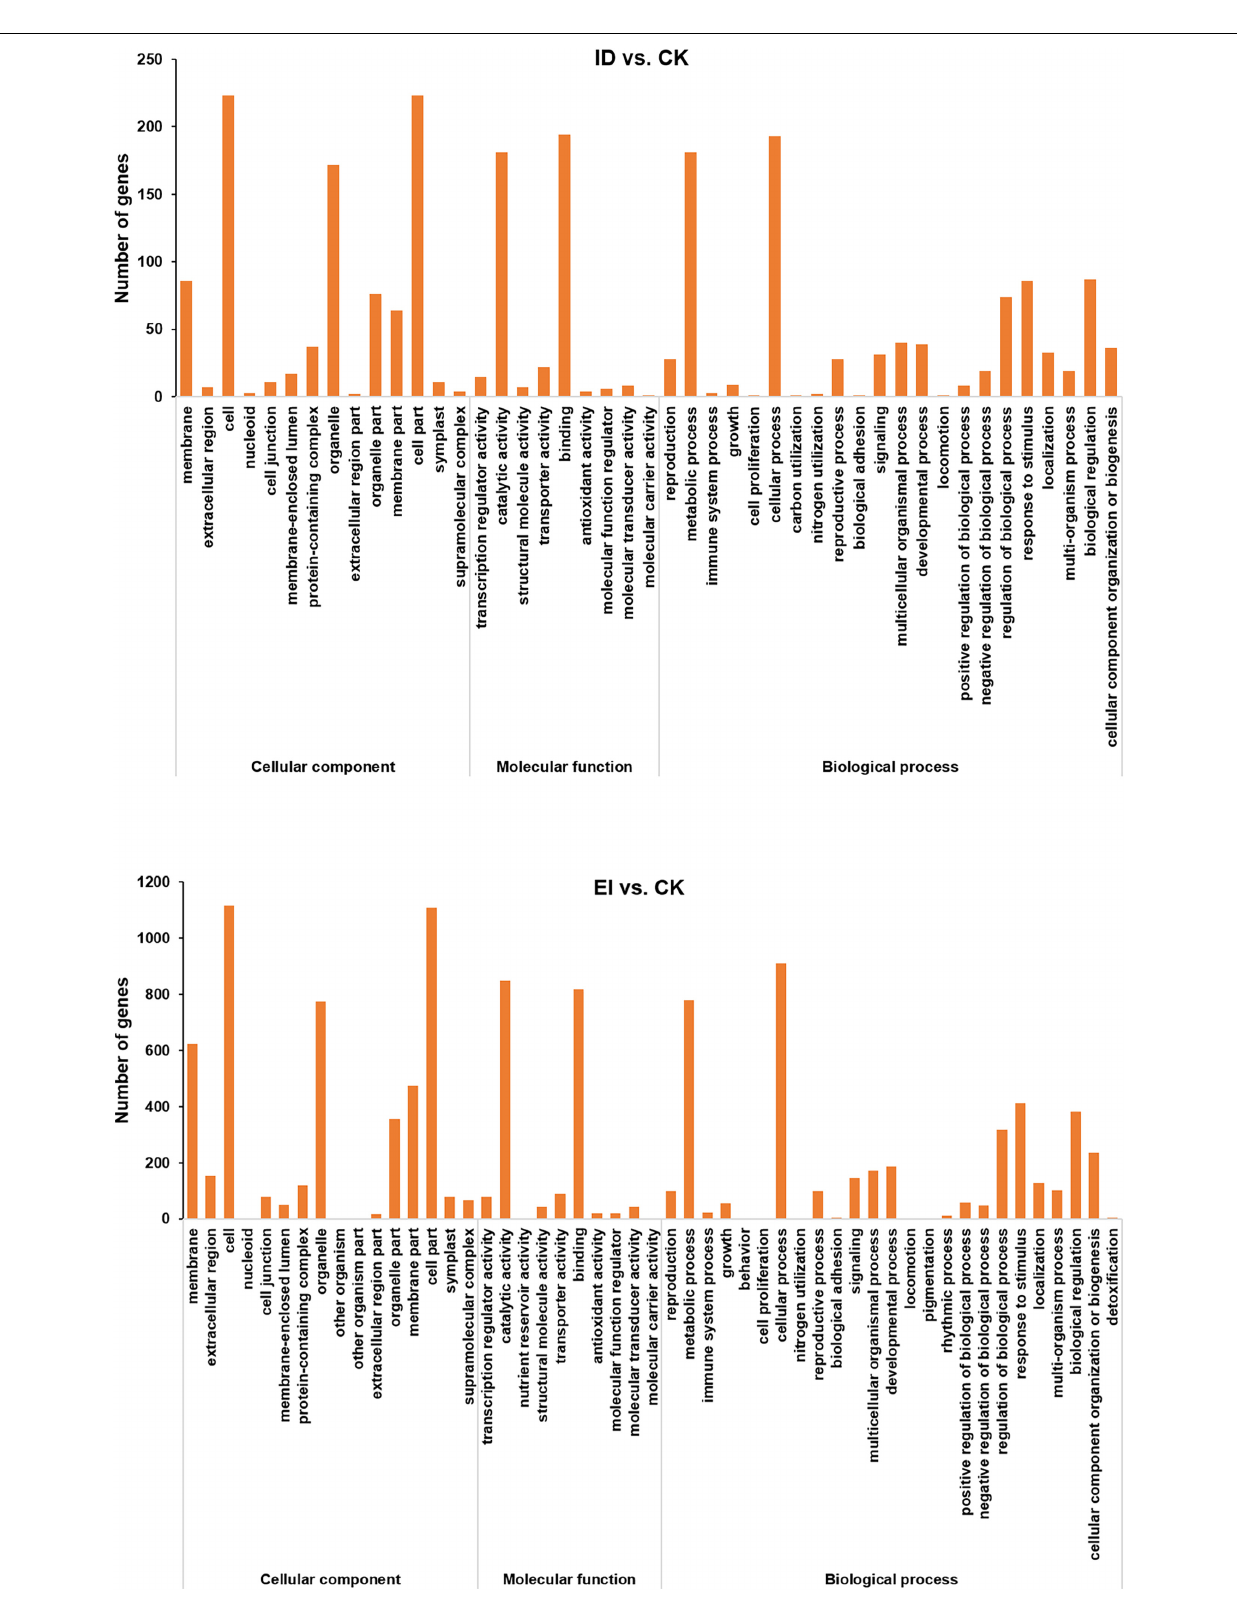
Frontiers in Plant Science |